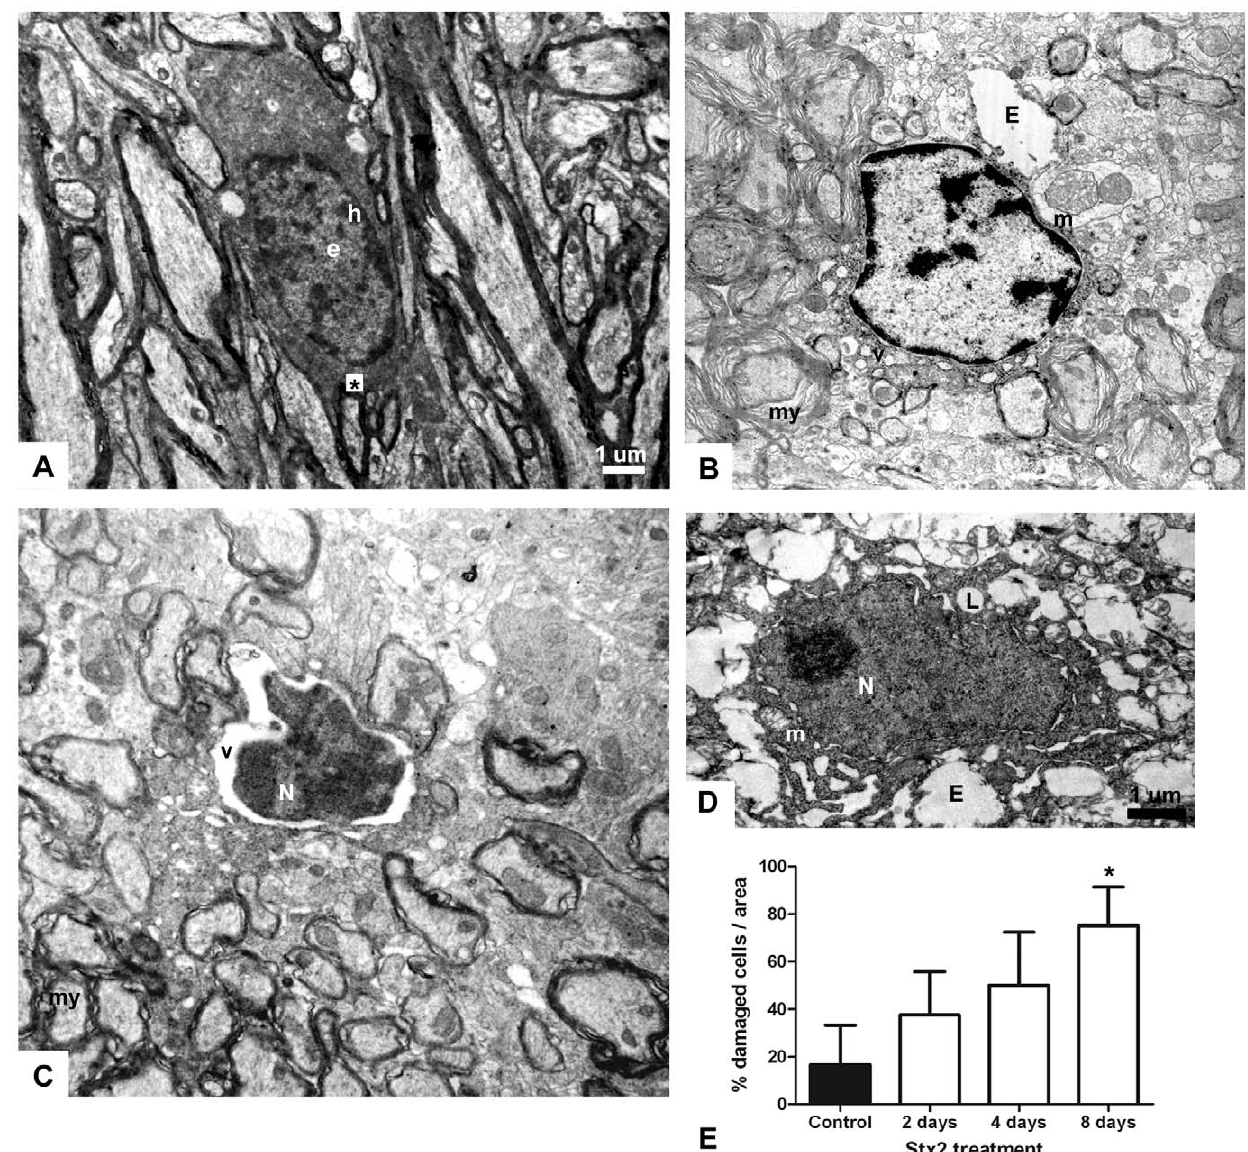
Figure 6. Intravenous administration of Stx2 causes pathological alterations in oligodendrocytes. Conserved oligodendrocyte in striata of brains treated with i.v. administration of vehicle; myelin formation in the cytosol (*) (A); electron-dense heterochromatin (h) mostly in the periphery of a rounded nucleus; euchromatin (e) present as electron-lucent areas of the inner nucleus. An irregular nucleus is observed 2 days after Stx2 treatment (B): vacuolated cytoplasm (v); disorganized myelin (my); Edema (E) and swollen mitochondria in the extracellular space. A shrunk and retracted nucleus (N) and perinuclear vacuolization (v) are observed on day 4 (C). Altered oligodendrocyte with a contrasted cytoplasm observed on day 8 (D); nucleus (N) and cytoplasm are difficult to differentiate; extended edema (E) and lack of myelin (L); swollen and disorganized cristae in mitochondria (m). The number of cells with edema increased with time (E). Results are expressed as a percentage of the total number of oligodendrocytes in an area of 3721 m m 2 . Data are mean 6 SEM of 6–8 experiments. An asterisk denotes statistical significance, p , 0.05. The scale bar in A applies to B and C.